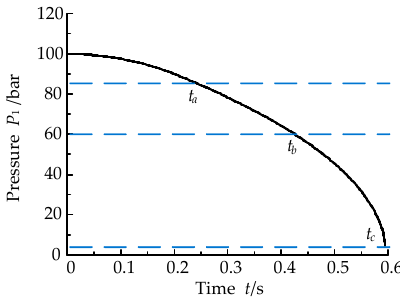
Figure 6. The switch point schematic diagram of the combined pressure-relief curve (CPRC). The pressure-relief process is a fast transient process. The control method is based on the pressure-relief curve deduced from the pressure-relief mechanism for open-loop control. It is